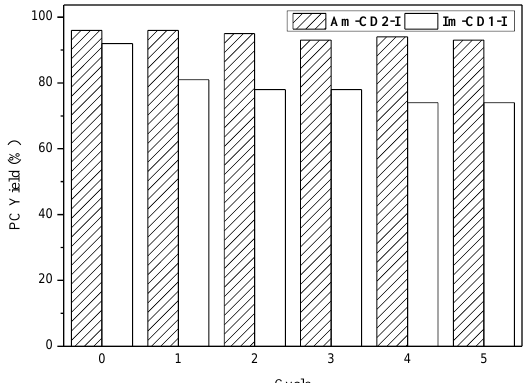
Figure 3. Catalyst recycling for coupling reaction catalyzed by Am-CD2-I and Im-CD1-I. Reaction condition for Am-CD2-I: PO (5 mL, 71.5 mmol), Am-CD2-I (1 mol%), CO 2 pressure 1 MPa, reaction temperature 130 °C, time 5 h. Reaction condition for Im-CD1-I: PO (5 mL, 71.5 mmol), Im-CD1-I (0.33 mol%), CO 2 pressure 3 MPa, reaction temperature 110 °C, time 3 h. The selectivity for target products are all > 99%.